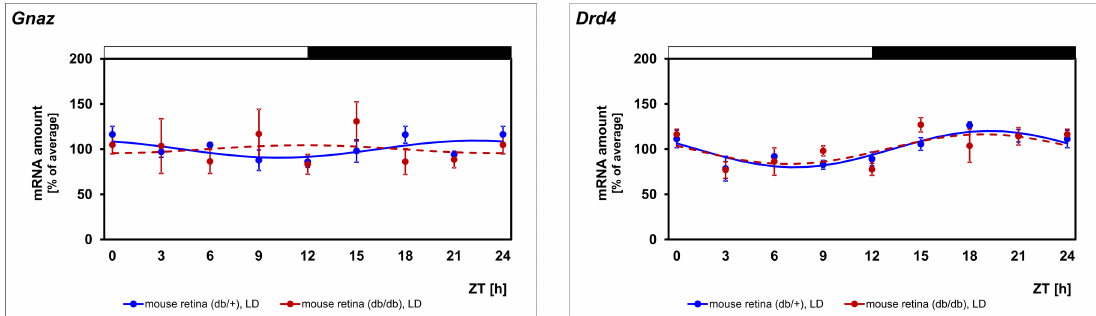
Fig 6. Daily profiling of Gnaz mRNA in diabetic retina. Transcript levels of Gnaz and Drd4 were recordedin non-diabetic ( db/ + ) mice (blue lines) versus diabetic ( db/db )mice (red lines) in preparations of the wholeretina under LD using qPCR. The mRNA levels are plotted as a function of ZT. The lines represent the periodicsinusoidal functions determined by cosinoranalysis(solid and brokenline for p < 0.05 and p > 0.05). Data represent a percentage of the averagevalue of the transcript amount duringthe 24-h period. Statistical analysisof transcriptional profilingis providedin Table 2. Note that Gnaz expressionis arrhythmic in diabeticmice. The value of ZT0 is plotted twice at both ZT0 and ZT24. The solid bars indicatethe dark period. Each value represents mean ± SEM (n = 4; each n represents one animal(two